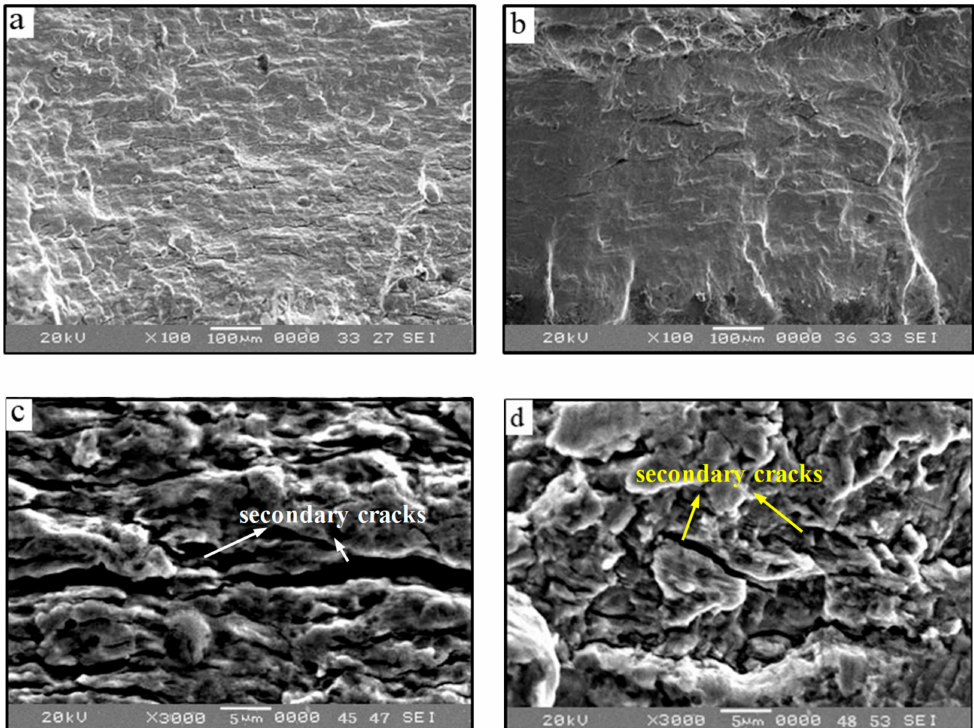
Figure 9. Fracture morphology of crack propagation zone: ( a , c ) Corrosion fatigue striations and secondary cracks of bare specimen; and ( b , d ) corrosion fatigue striations and secondary cracks of coated